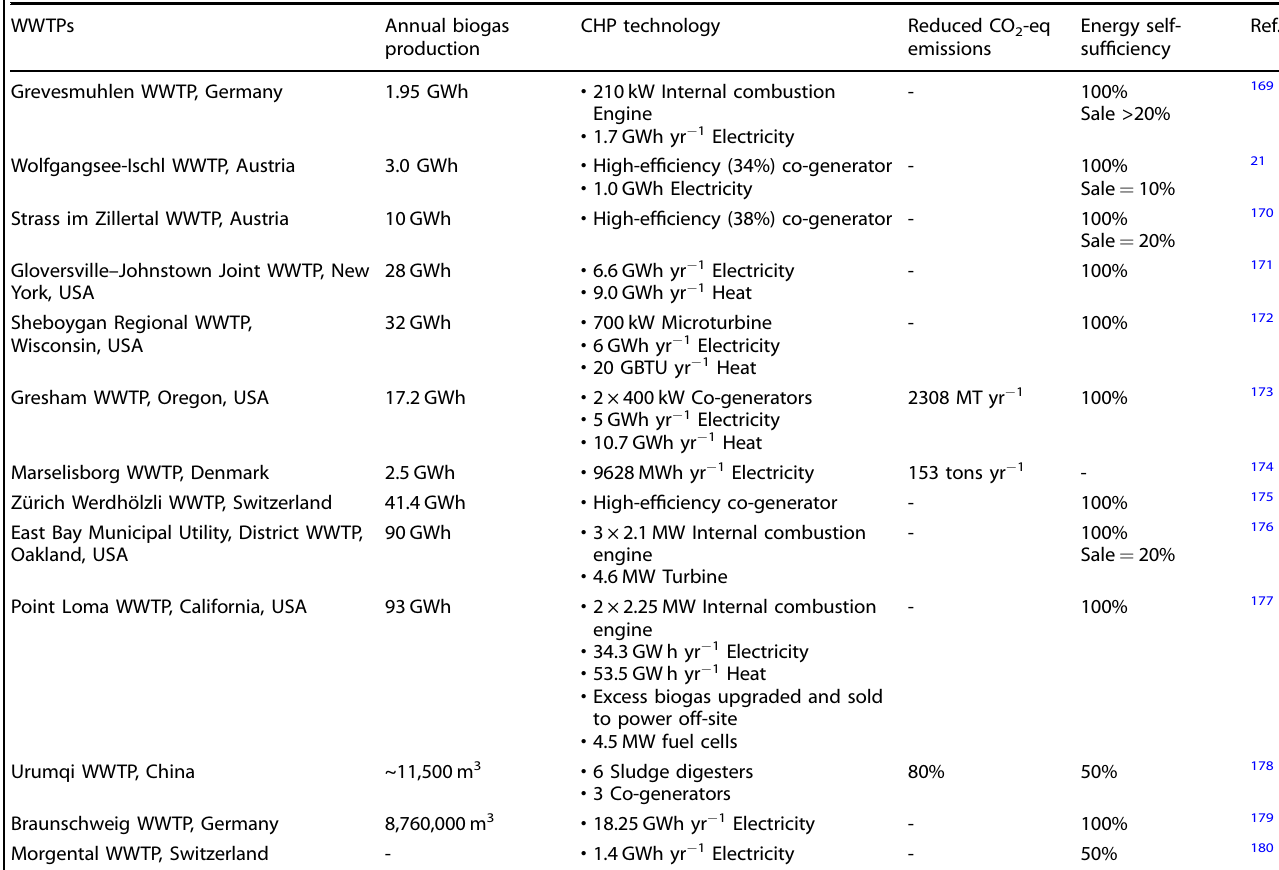
Table 1. Energy-positive wastewater treatment utilities: exemplary case